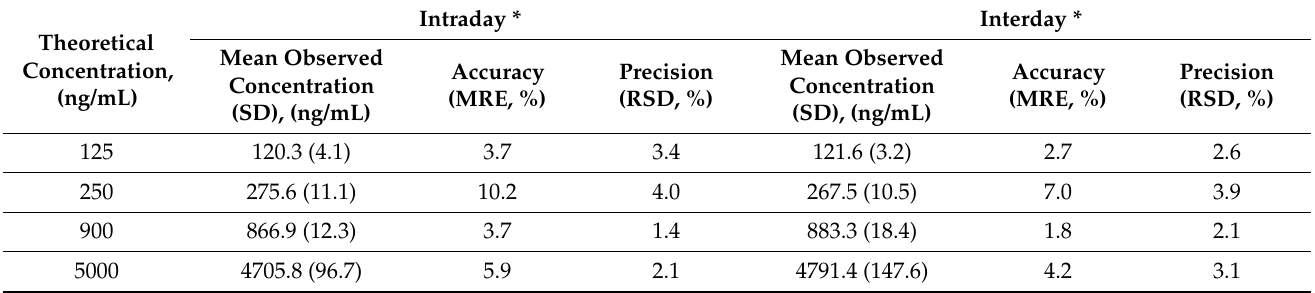
Table 2. Accuracy and precision of nilotinib determination in human plasma.